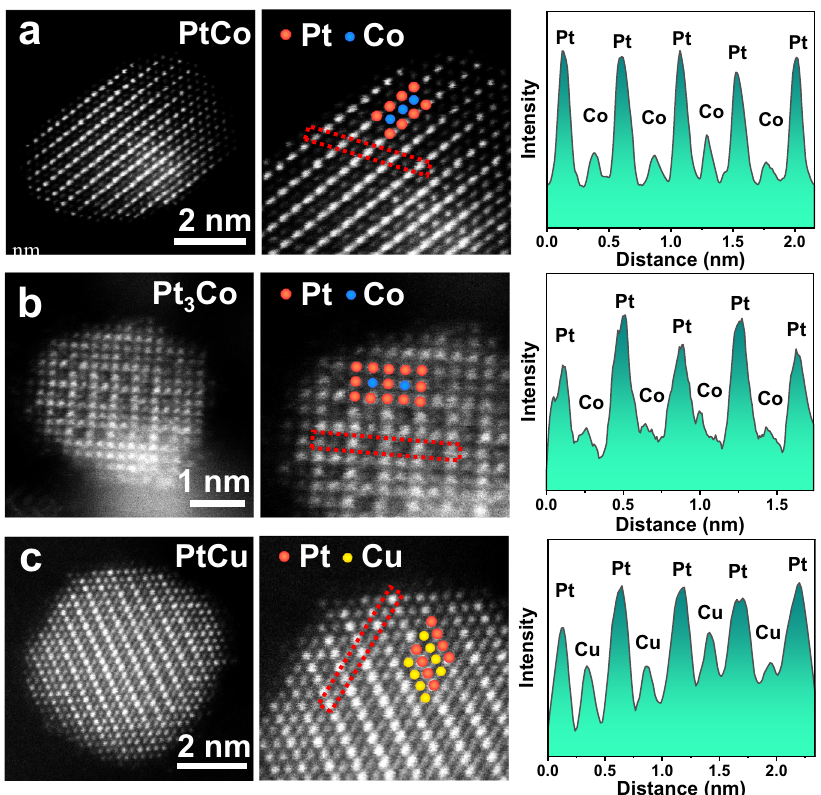
Fig. 4 | Atomic scale HAADF-STEM characterization of Pt-IMCs. Atomic- resolutionHAADF-STEMimagesandalternativeintensitypro fi lesofPtCo( a ),Pt 3 Co